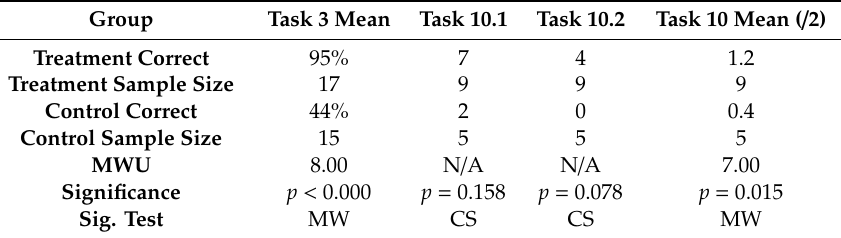
Table 3. Websites’ locations tasks.